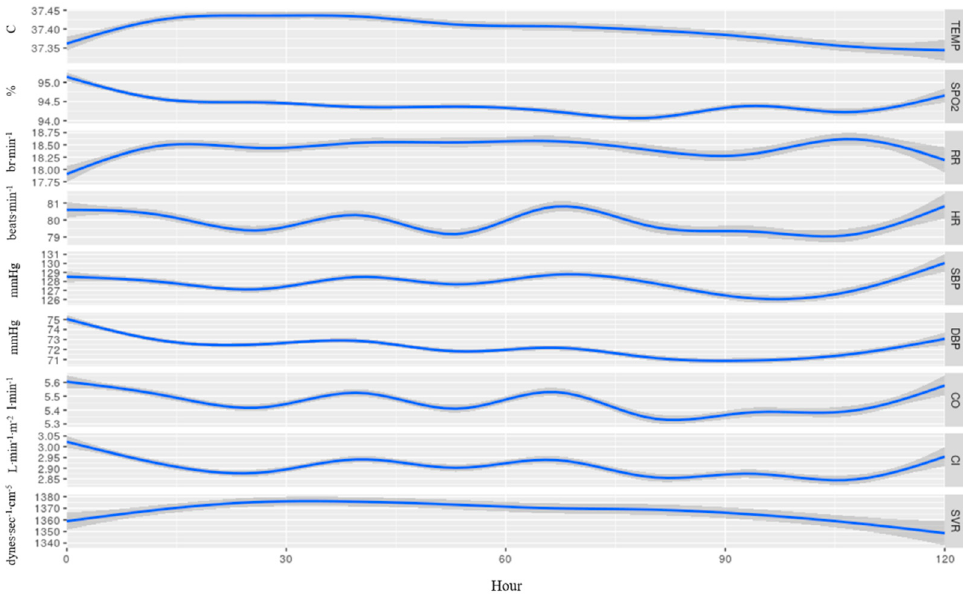
Figure 3. Average recorded measurements among 130 patients that were continuously monitored for 5 days from admission, without separation to sub-groups. Temp, temperature; SpO 2 , blood oxygen saturation; RR, respiratory rate; HR, heart rate; SBP, systolic blood pressure; DBP, diastolic blood pressure; CO, cardiac output; CI, cardiac index; SVR, systemic vascular resistance. The blue line represents the mean value of each vital and the 95% confidence interval appears in gray.